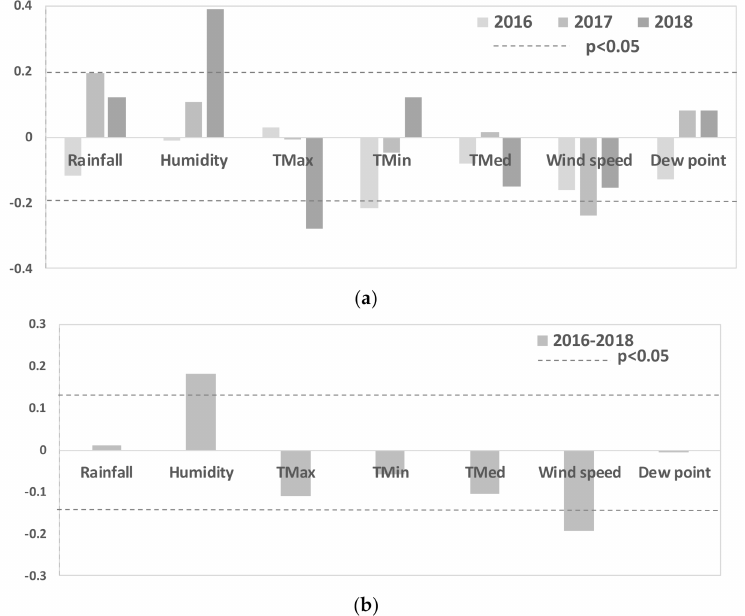
Figure 6. Spearman correlations between daily Olea pollen concentrations and the main meteorologi- cal variables considering all years of the study separately ( a ) and together ( b